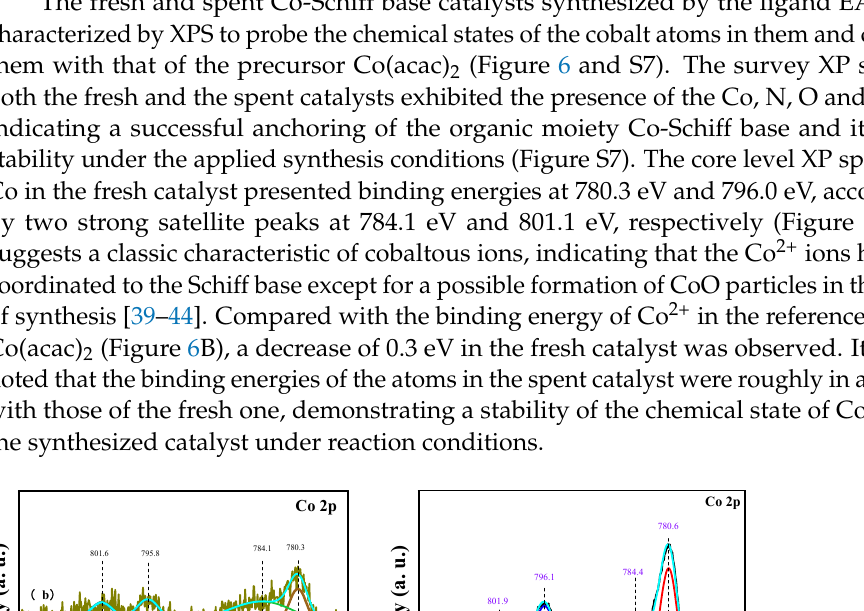
Figure 5. TGA ( A ) and DTG ( B ) curves of the support SiO 2 , the intermediate SiO 2 ‐ APTES and the covalently anchored catalyst SiO 2 ‐ APTES ‐ EASA ‐ Co.